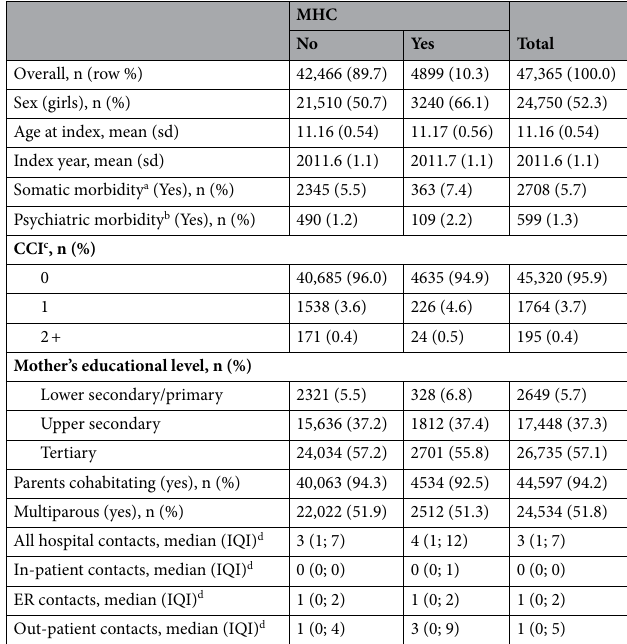
Table 2. Characteristics of responders by multiple health complaints (MHC) at the 11-year follow-up of the Danish National Birth Cohort. a As defined in methods section. b Any ICD-10 F-diagnosis. c Charlson Comorbidity Index. d From index date to end of follow-up. IQI reflects the 25–75-percentile interquartile interval. To comply with Danish data-protection legislation, we report pseudo-medians and pseudo- interquartile intervals, calculated by ordering all observations and averaging the 5 values closest to the relevant percentile.